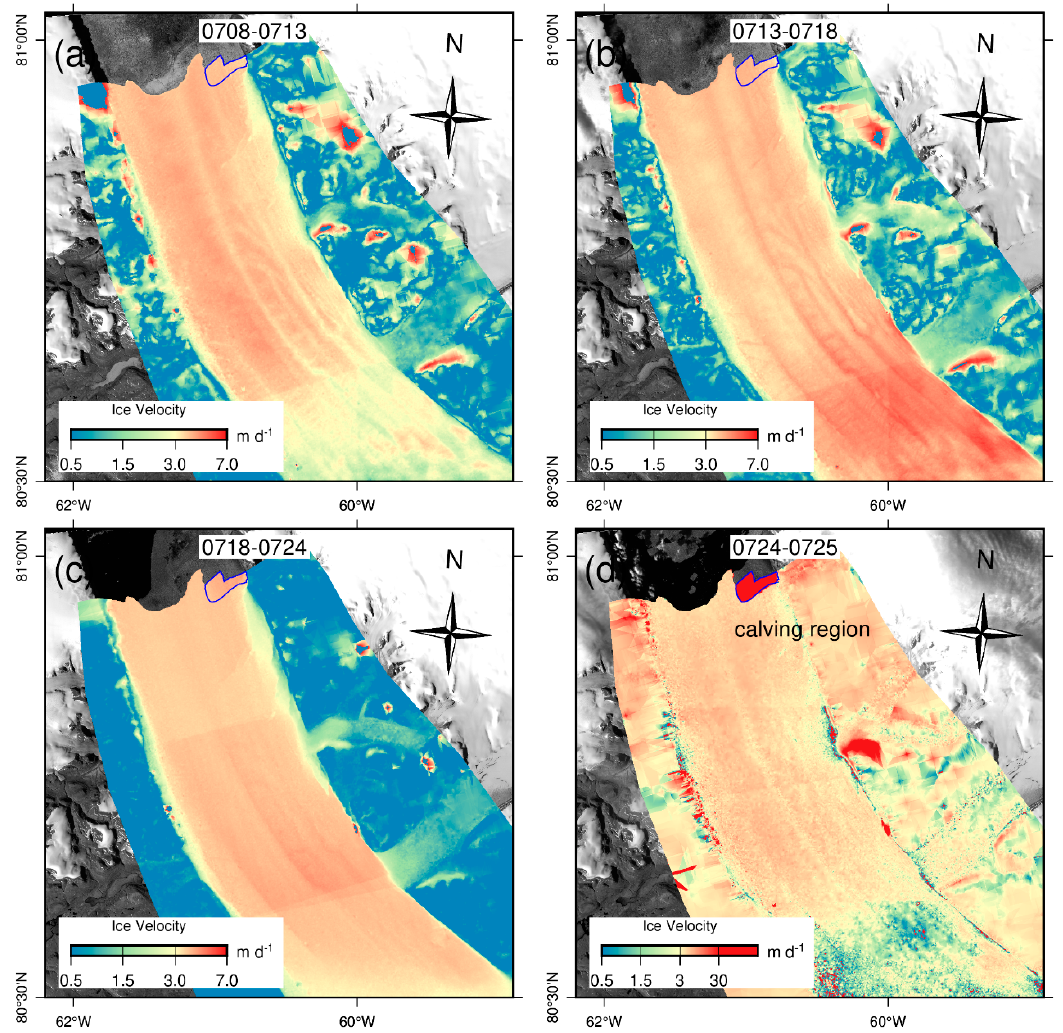
Figure 3. Surface daily velocity field of the Petermann glacier in four periods of July 2017, prior to the frontal collapse. ( a ) The daily velocity field from 08 July to 13 July in 2017; ( b ) the daily velocity field from 13 July to 18 July in 2017; ( c ) the daily velocity field from 18 July to 24 July in 2017; and ( d ) the daily velocity field from 24 July to 25 July in 2017.